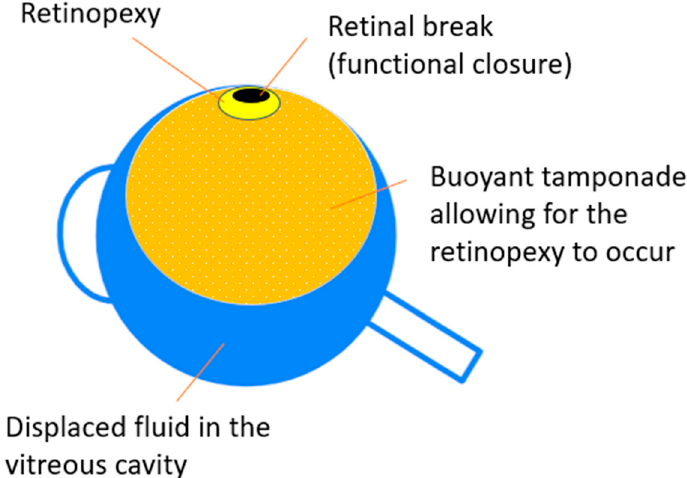
Figure 1. General representation of the mechanism of buoyant vitreous tamponades. The tamponade allows for the chorioretinal contact and adherence to occur, while displacing the intravitreal fluid, potentially containing proinflammatory cytokines. The bubble tamponades the retinal break and blocks the intravitreal fluid from passing through the break into the subretinal space until retinopexy takes place.